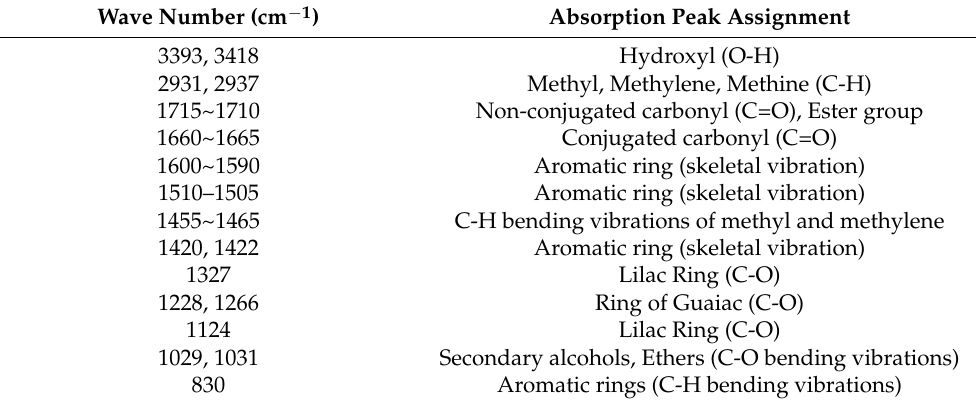
Figure 2. FTIR spectra of Chinese fir DEL and birch DEL. Table 1. Infrared characteristic absorption peaks of Chinese fir and birch DEL.